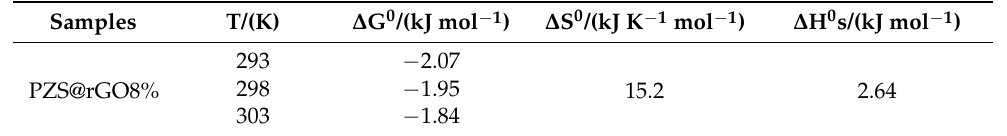
Table 3. Thermodynamics parameters for